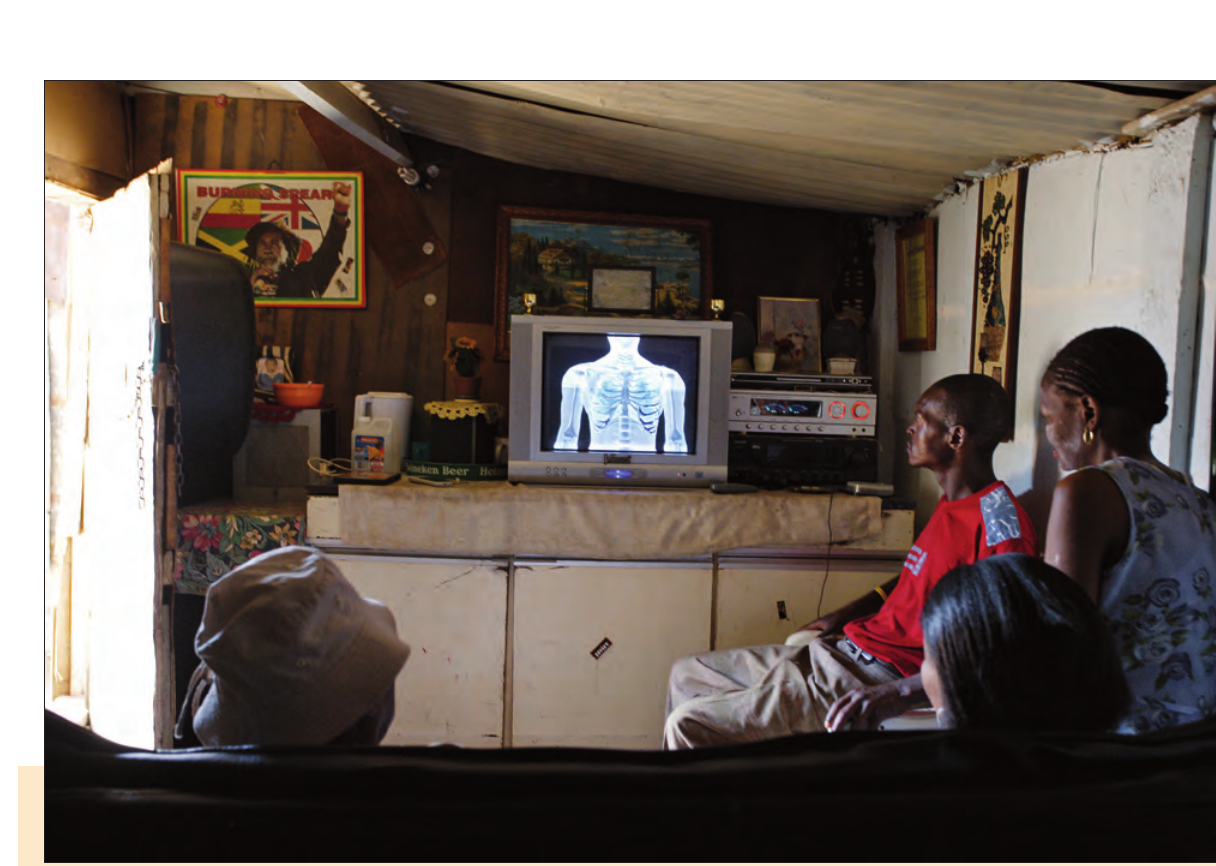
TB and is on antiretrovirals. She was bedridden but is starting to feel better and able to walk around the house. Her brother is also showing symptoms of TB, and during this visit the Red Cross managed to convince him to be